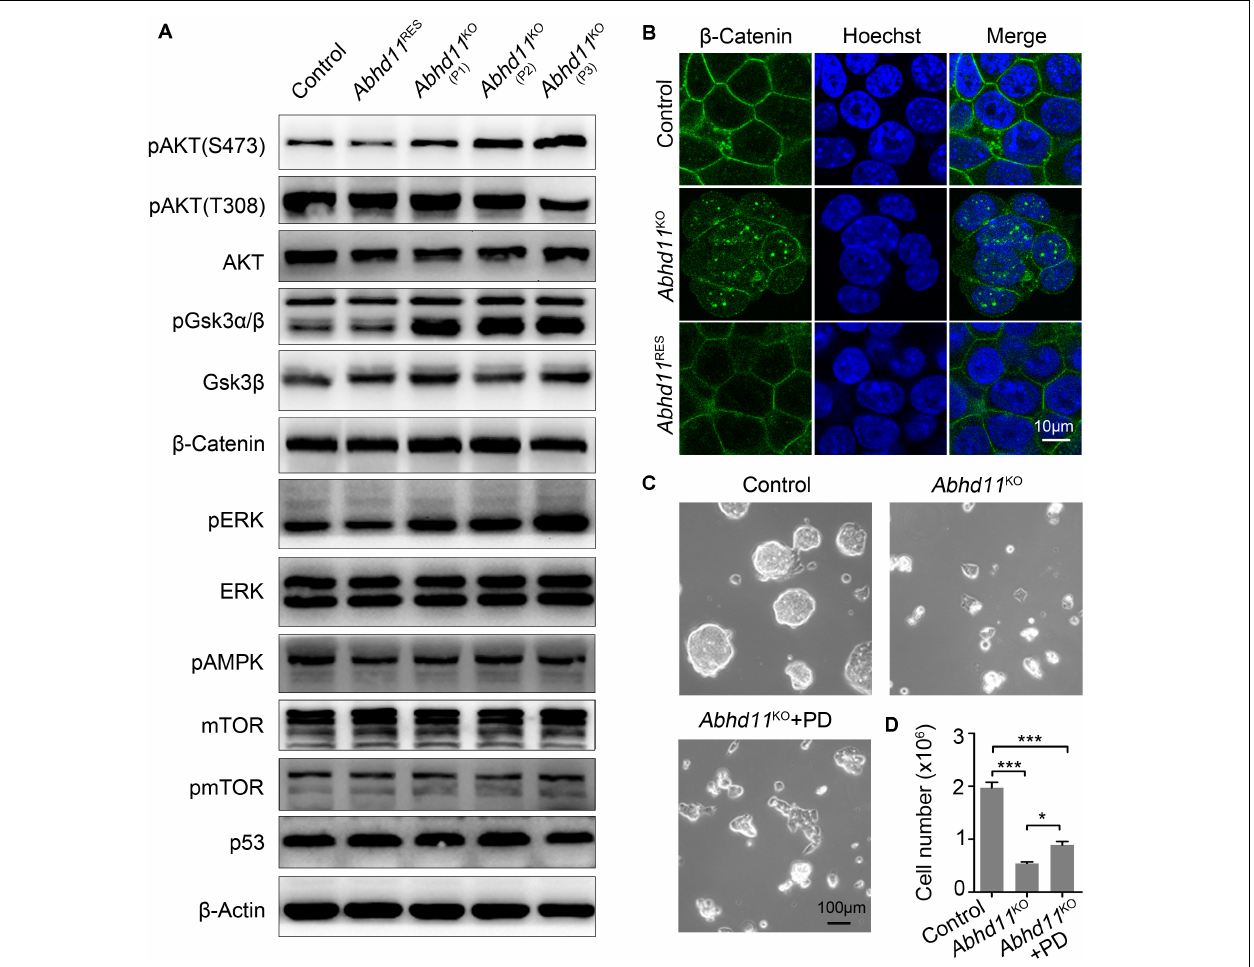
FIGURE 6 | Abhd11 KO results in disturbances in signal transduction. (A) Western blot analysis using antibodies as indicated. (B) Immunofluorescence analysis of β -Catenin in the indicated cells. Cells were counterstained with hoechst. (C) Representative morphology of colonies formed by control and P3 Abhd11 KO ESCs. Abhd11 KO ESCs were plated in duplicate and treated with 1 µ M PD0325901 ( Abhd11 KO + PD). (D) Cell numbers in panel C were counted. Data were represented as mean ± s.d. from three independent experiments. * p < 0.05, *** p <